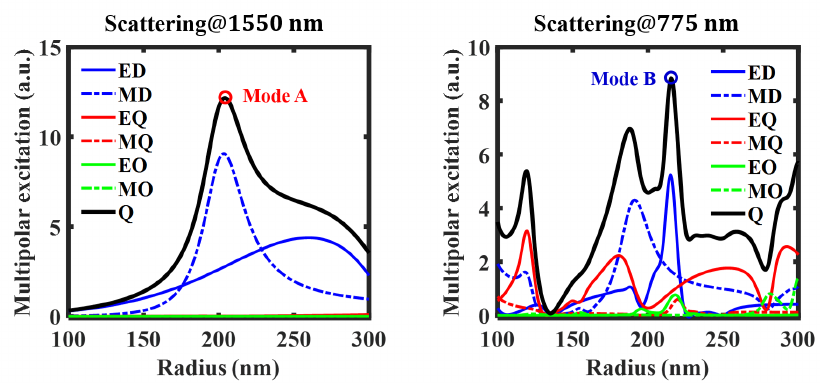
Figure 1. Multipolar decomposition of linear light scattering by AlGaAs nanodiscs with different radii for normal plane wave incidence at the wavelengths of ( a ) λ = 1550 nm and ( b ) λ = 775 nm, respectively. ED, electric dipole; MD, magnetic dipole; EQ, electric quadrupole; MQ, magnetic quadrupole; EO, electric octupole; MO, magnetic quadrupole.